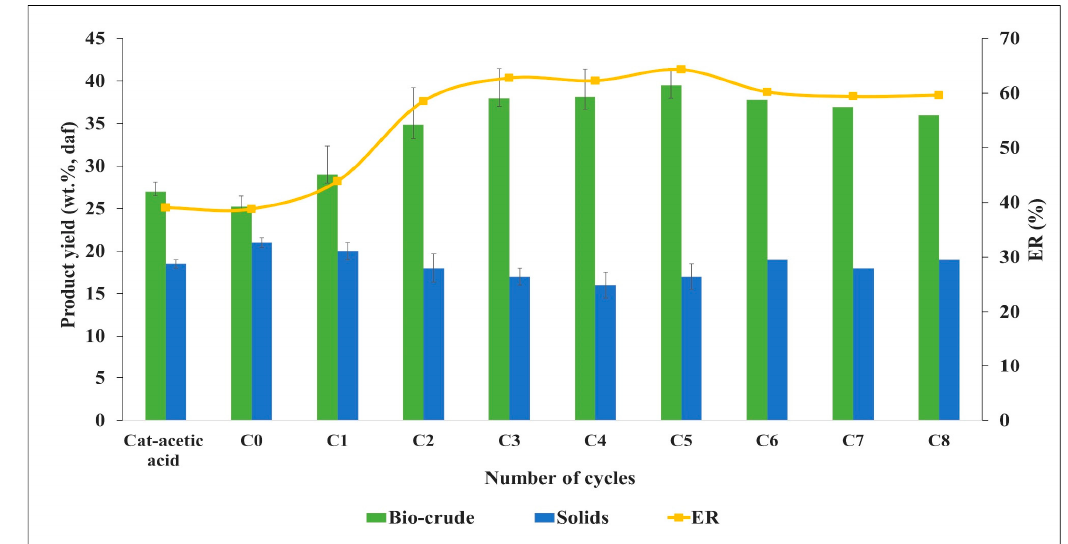
ff ect of aqueous phase recycling on product Figure 4. Effect of aqueous phase recycling on product yield. Figure 4. E